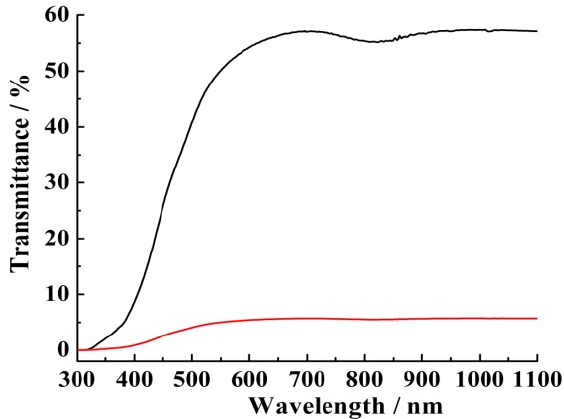
Figure 8. Transmittance spectra of APCVD V 2 O 5 at 550 °C in the colored (red line) at − 1 V and bleached (black line) states at +1 V.